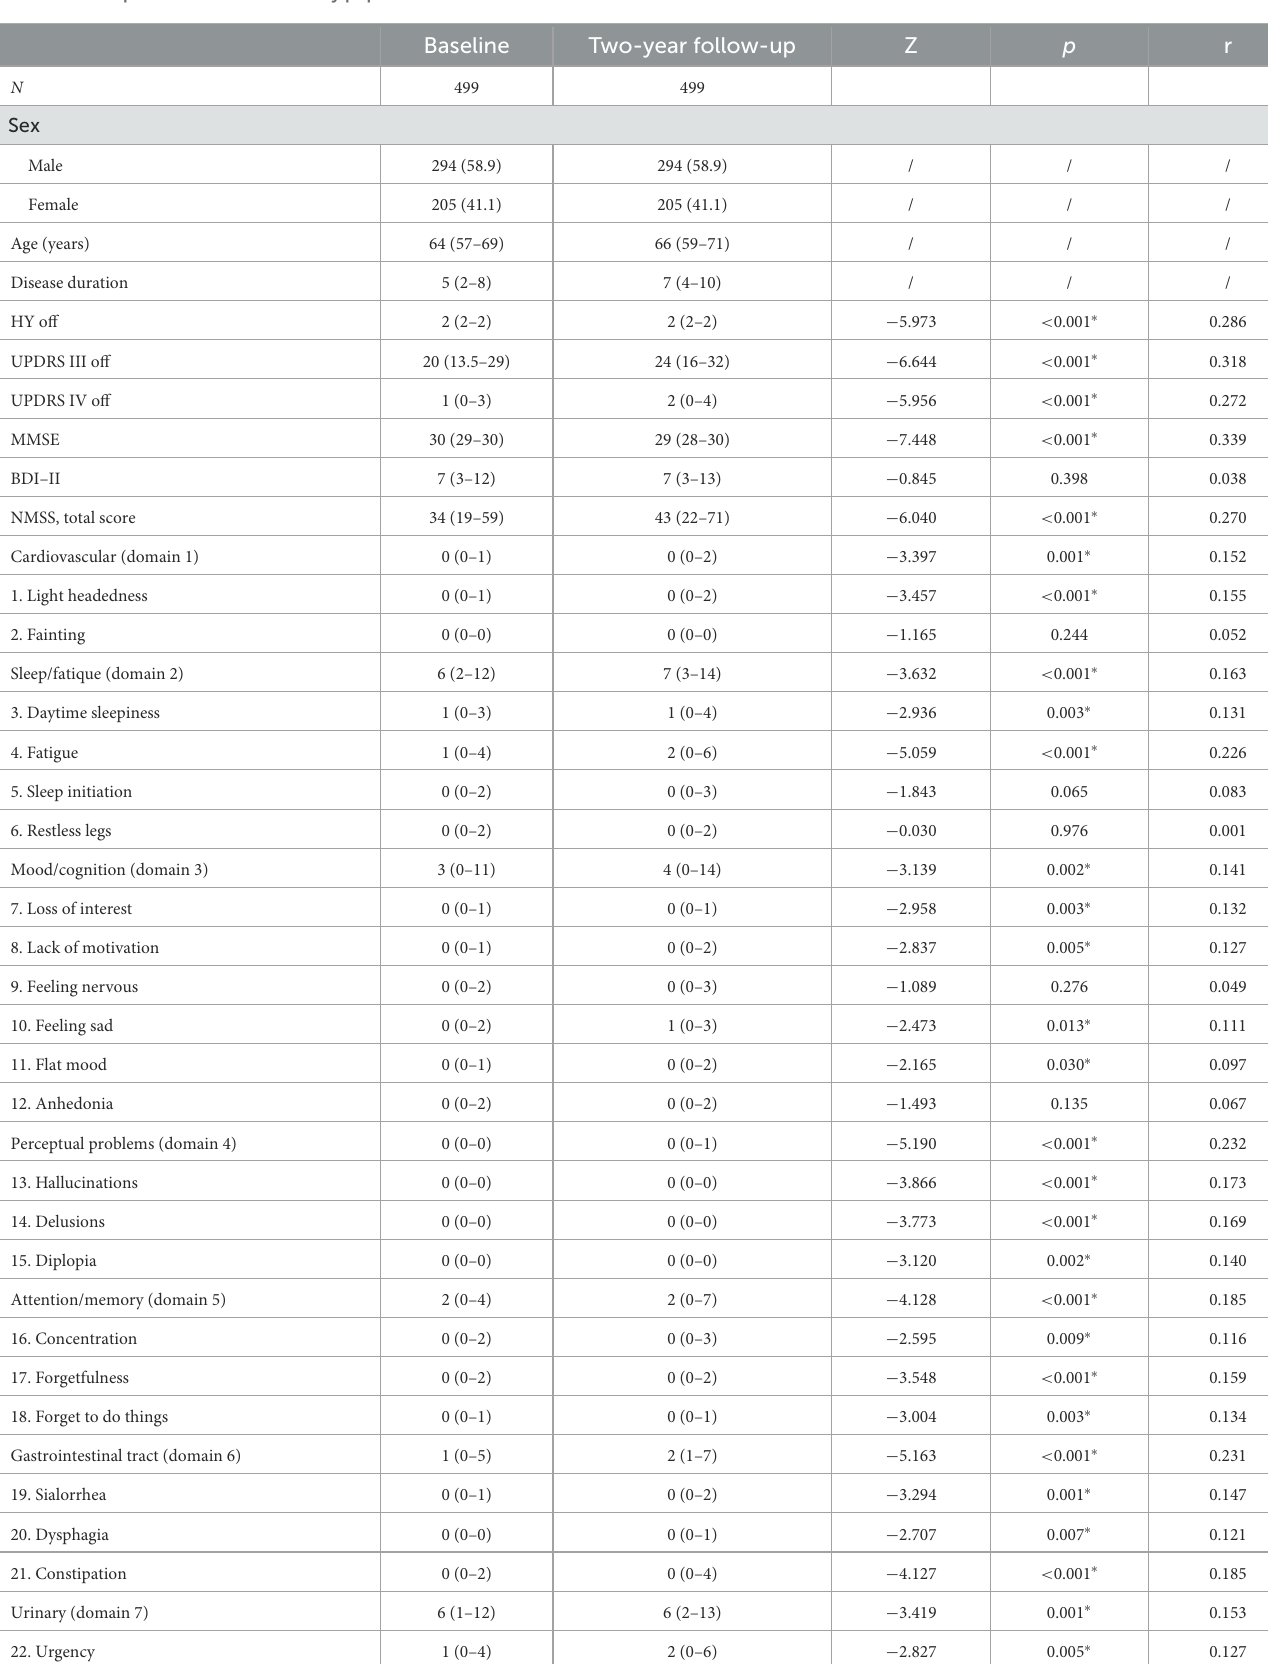
TABLE 1 Descriptive statistics of the study population and the